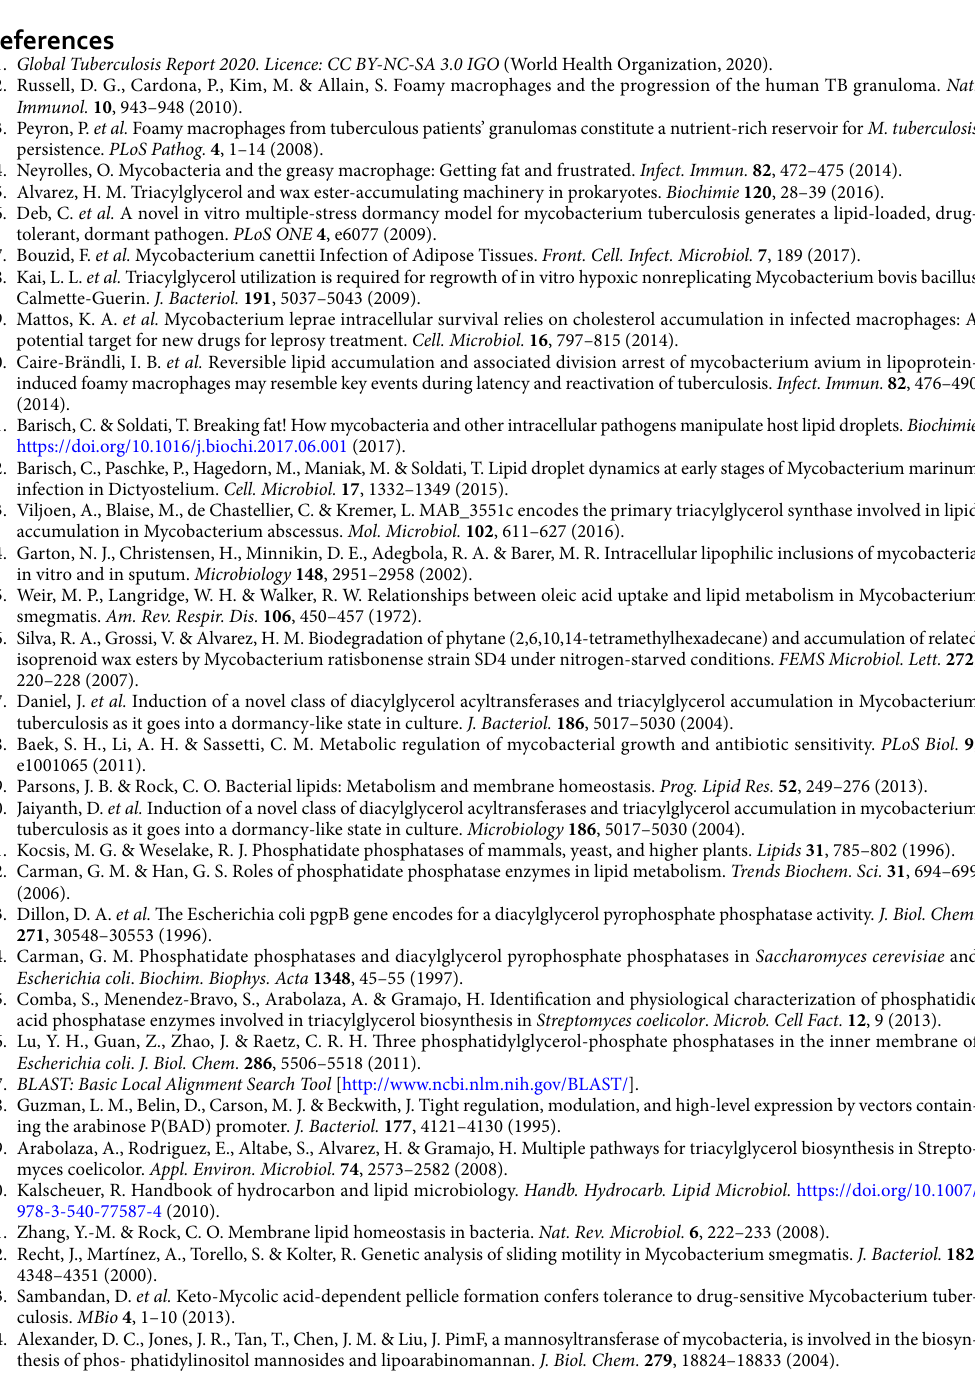
figure legends. Statistical significance was accepted at p < 0.05. Curve fitting was done using the following equation and parameters: Four - parameter logistic curve ( 4 PL ) : Y = OD0 + ( ODf − OD0 ) (cid:31)(cid:30) 1 + 10 ( Log ( t 1 / 2 ) − X ∗ HillSlope ) Parameters: t 1/2 is the time that gives an OD at half way between OD 0 (initial OD) and OD f (final OD).